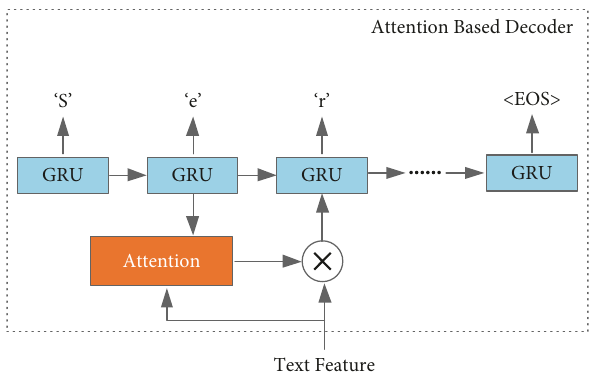
Figure 5: Structure of the attention-based decoder in the recog- nition